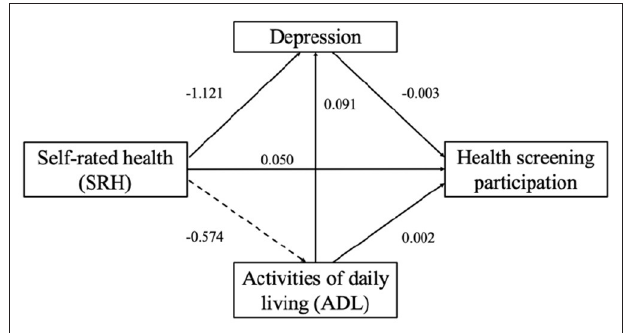
FIGURE 1 | Structural equation model for the relationship between SRH, ADL, depression and health screening participations.